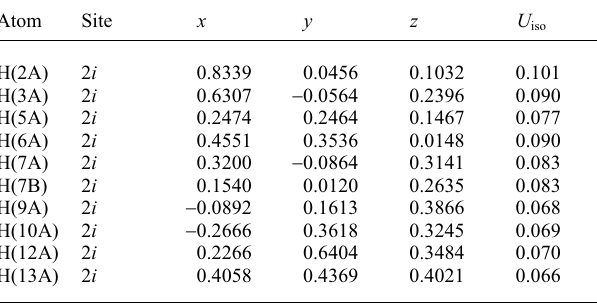
Table 2. Atomic coordinates and displacement parameters (in Å 2 )